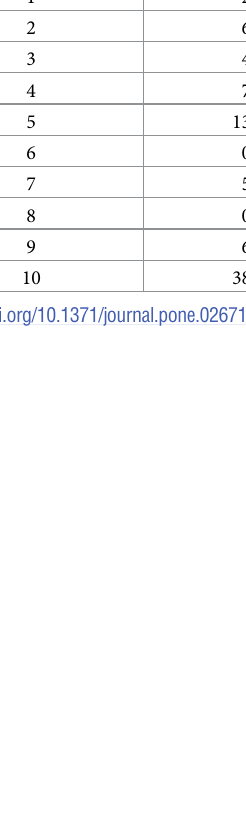
Table 4. Pre-sham treatment (control group) fitting parameters for Fung-type SEF. Heart